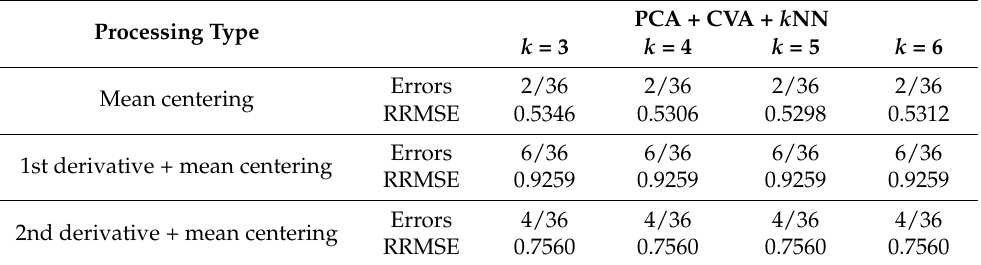
Table 7. Study No. 2 with MIR spectral data. Prediction-set classification errors (36 samples).